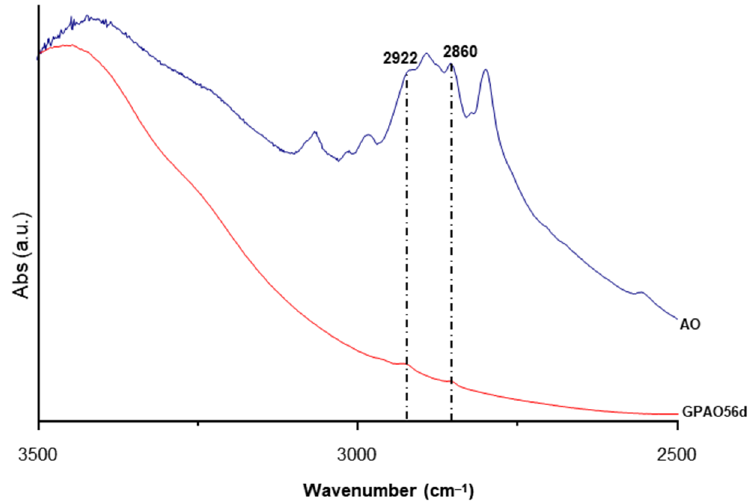
Figure 4. FT-IR spectrum of AO and GPAO aged up to 56 days.